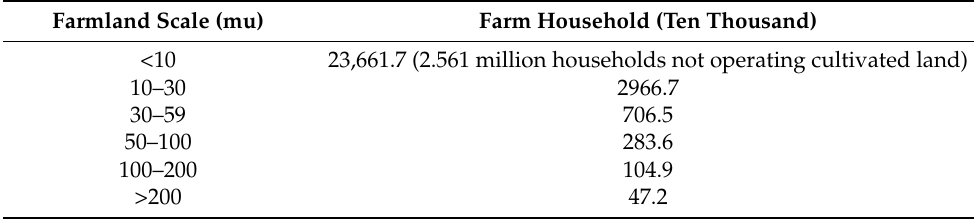
Table 5. Farmland scale of farmers in China, 2020 1 . Farmland Scale